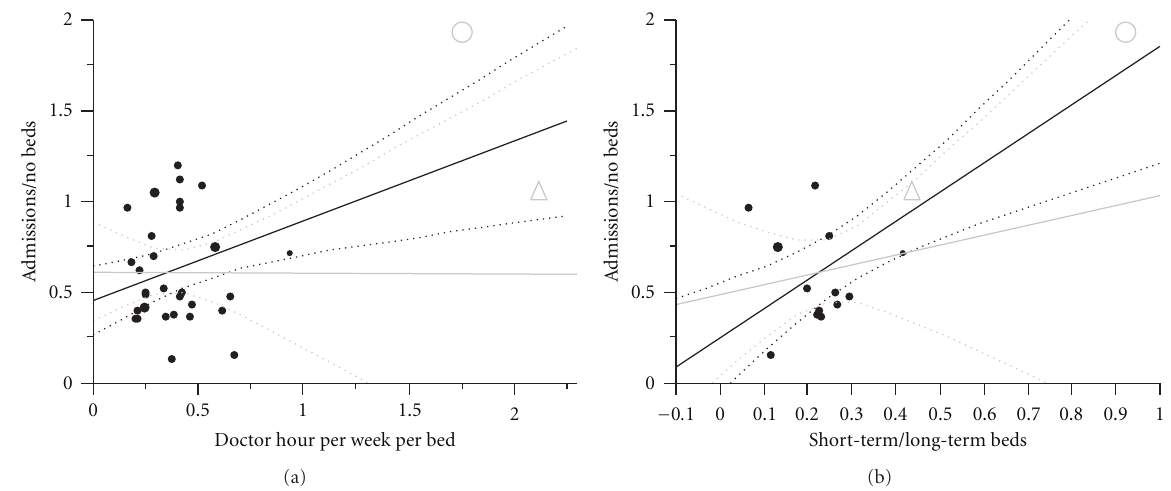
Figure 6: (a) Admissionscorrelated to physician hours per bed per week ( N = 32, R 2 = 0 . 24, P = . 0041, y = 0 . 4396 x +0 . 4549),grey line with two institutions with high number of short-term beds and extra sta ffi ng excluded. (b) Admissions correlated to short-term/long-term beds. Institutions with zero short-term beds excluded from analysis. Grey line with one institution with almost only short-term beds excluded. ( N = 15, R 2 = 0 . 55 / 0 . 04, P = . 0016 / 0 . 51, y = 1 . 6074 x + 0 . 2488 for grey line). Dotted lines are confidence curves for regression lines. The grey circle represents institution 32 (92% short-term beds), and the grey triangle represents institution 31 (43% short-term